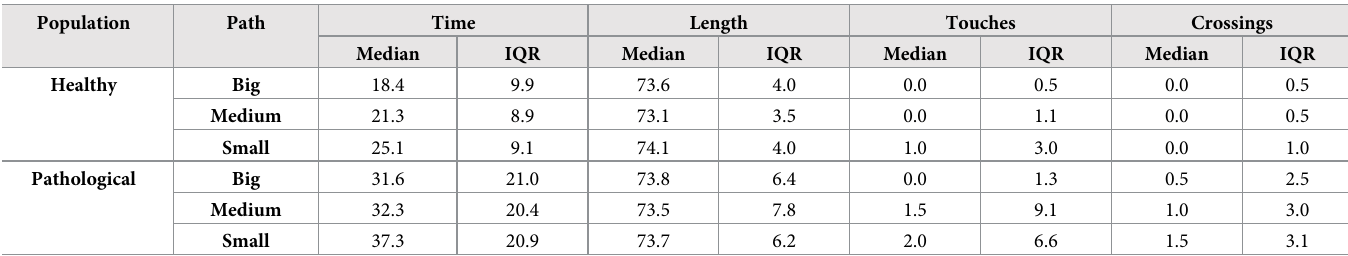
Table 2. Median and Inter-Quartile Ranges (IQRs) of time, length, touches, and crossings in healthy and pathological subjects, divided by path size. Population Path Healthy Big Medium Small Pathological